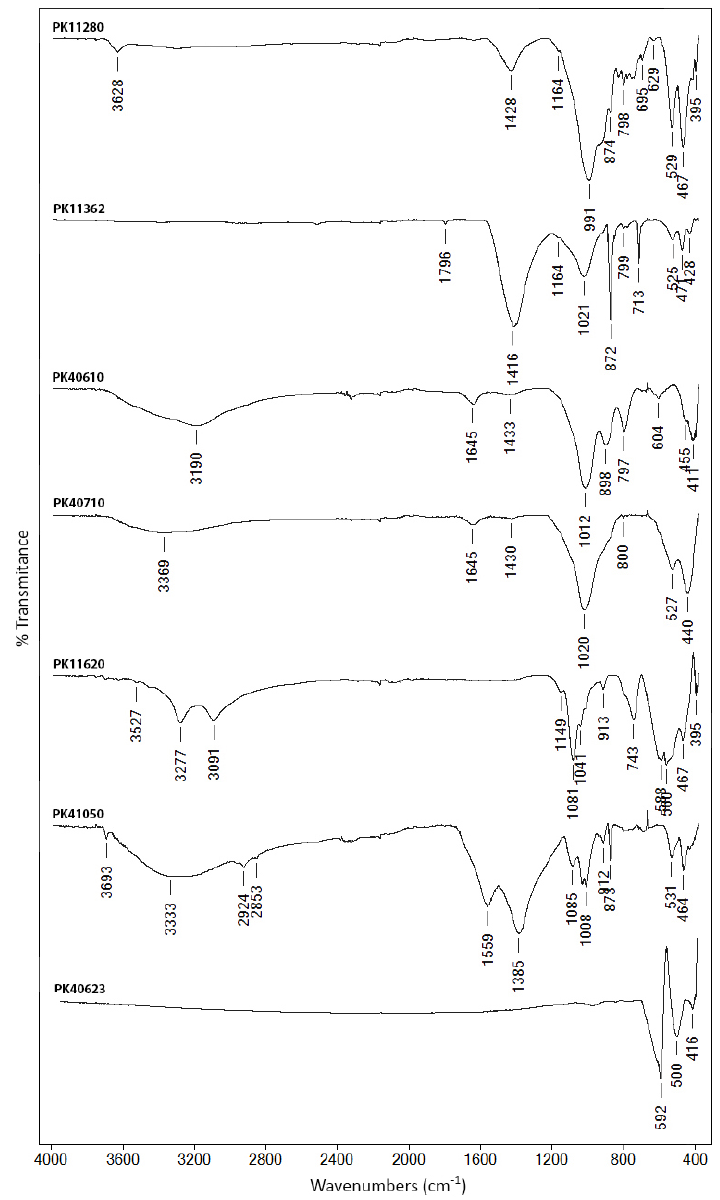
Figure 5. FTIR spectra registered on the brown and black earth pigments.